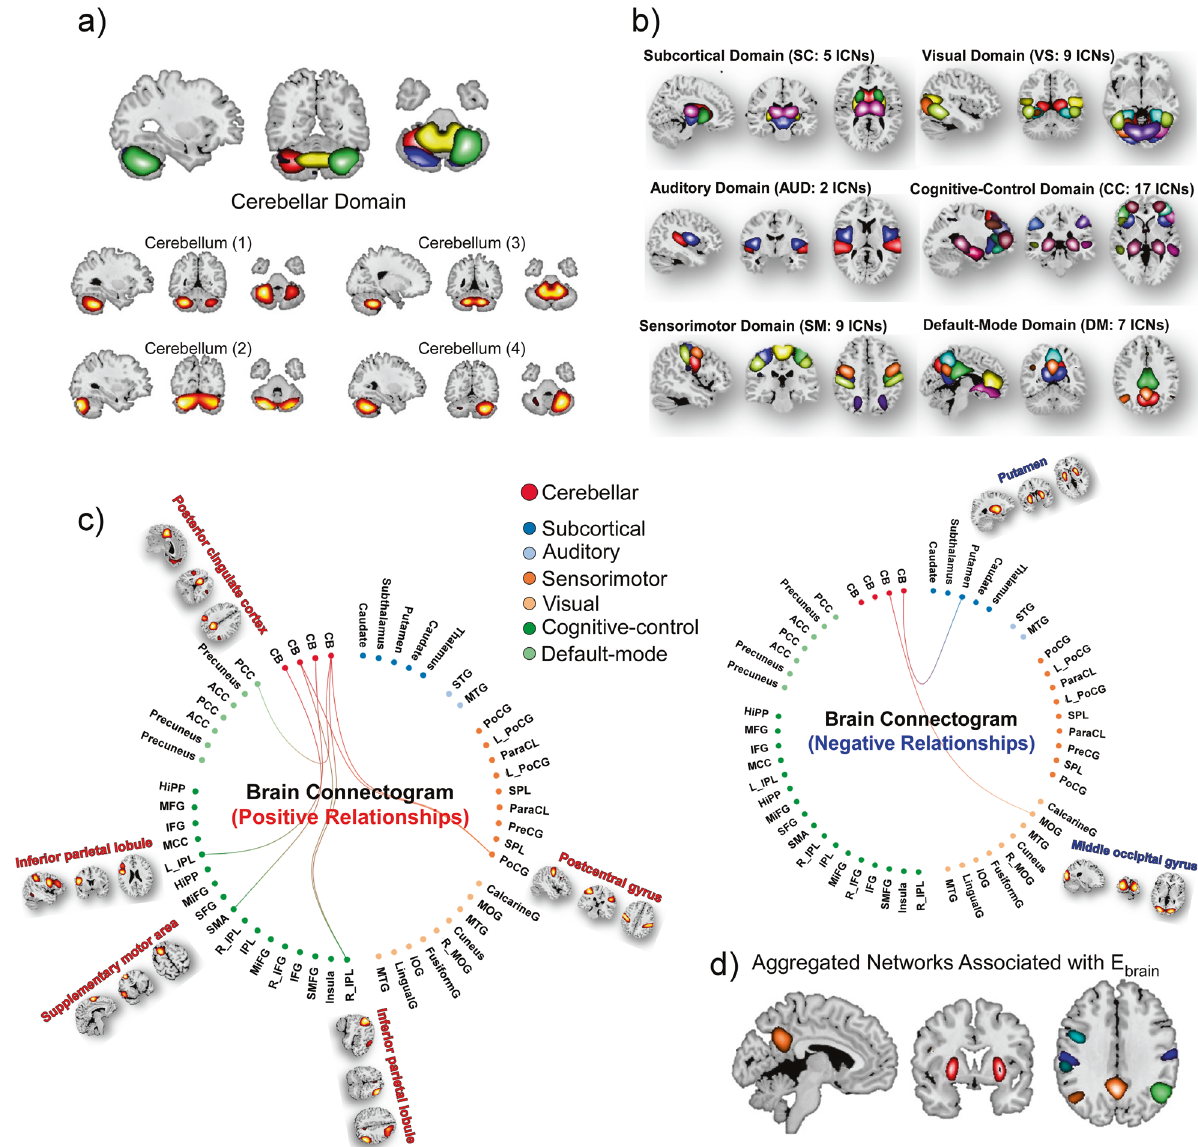
Fig. 2 Spatial maps of ICNs and E brain related cerebro-cerebellar FNC. a , b Four cerebellar and 49 cerebral networks are identi fi ed via the Neuromark framework, arranging into CB, SC, AUD, SM, VS, CC, and DM domains. c , d Functional connectogram of FNC with changes signi fi cantly associated with E brain ( p < 0.05). e spatial maps of aggregated cerebral networks that with cerebro-cerebellar FNC related to E brain . ICN intrinsic connectivity network, E brain the 90 th percentile of electric fi eld magnitude in the brain, FNC functional network connectivity,